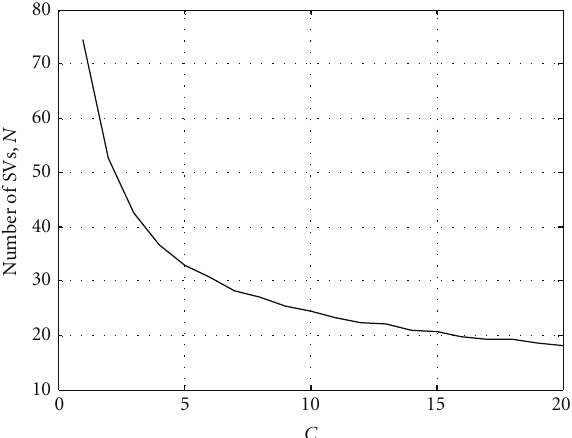
Figure 3: Number of support vectors from the SVM model for di ff erent C parameters, n =